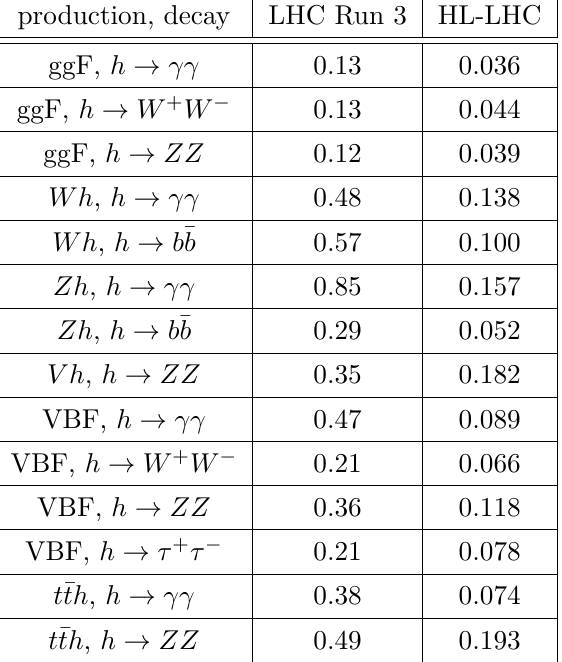
Table 3. Relative total uncertainties ∆ f on the Higgs signal strengths defined in (4.10). The i quoted LHC Run 3 and HL-LHC numbers are taken from [83] and [82], respectively. Further information can be found in the main